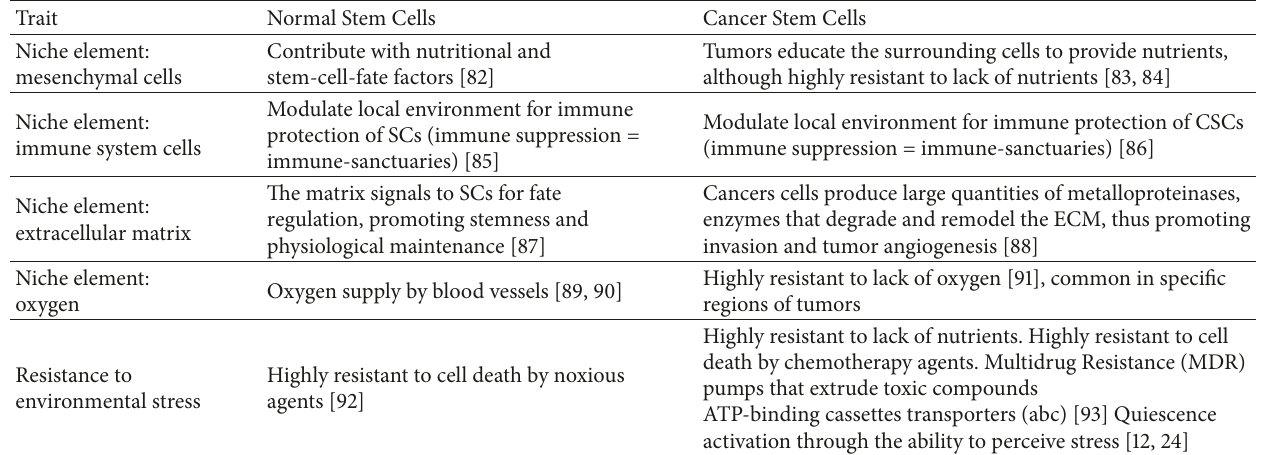
Table 2: Comparison of traits of normal Stem Cells and Cancer Stem Cell (CSCs)